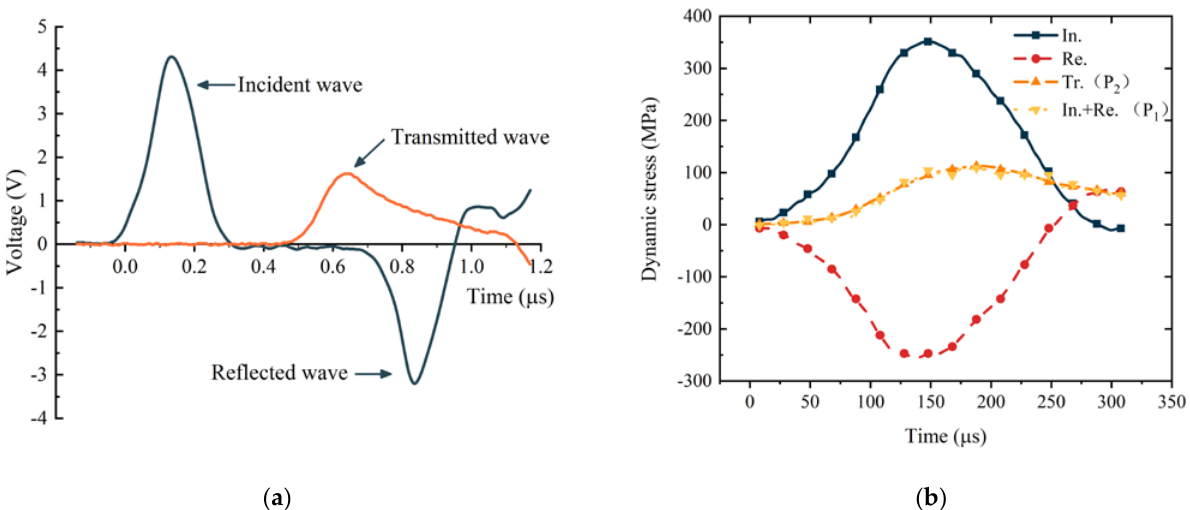
Figure 6. Dynamic loading process of coal specimen: ( a ) original stress waveform. ( b ) dynamic stress balance.